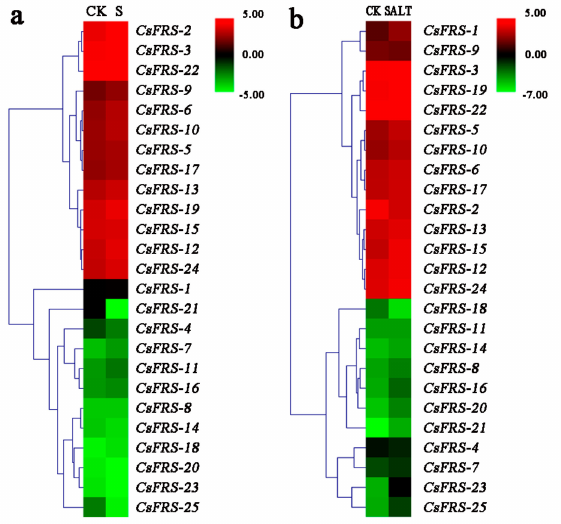
Figure 6. Expression of tea plant CsFHY3/FAR1 transcripts in response to salt ( a ) and shade ( b ) stress. CK: control; S: shade stress; SALT: salt